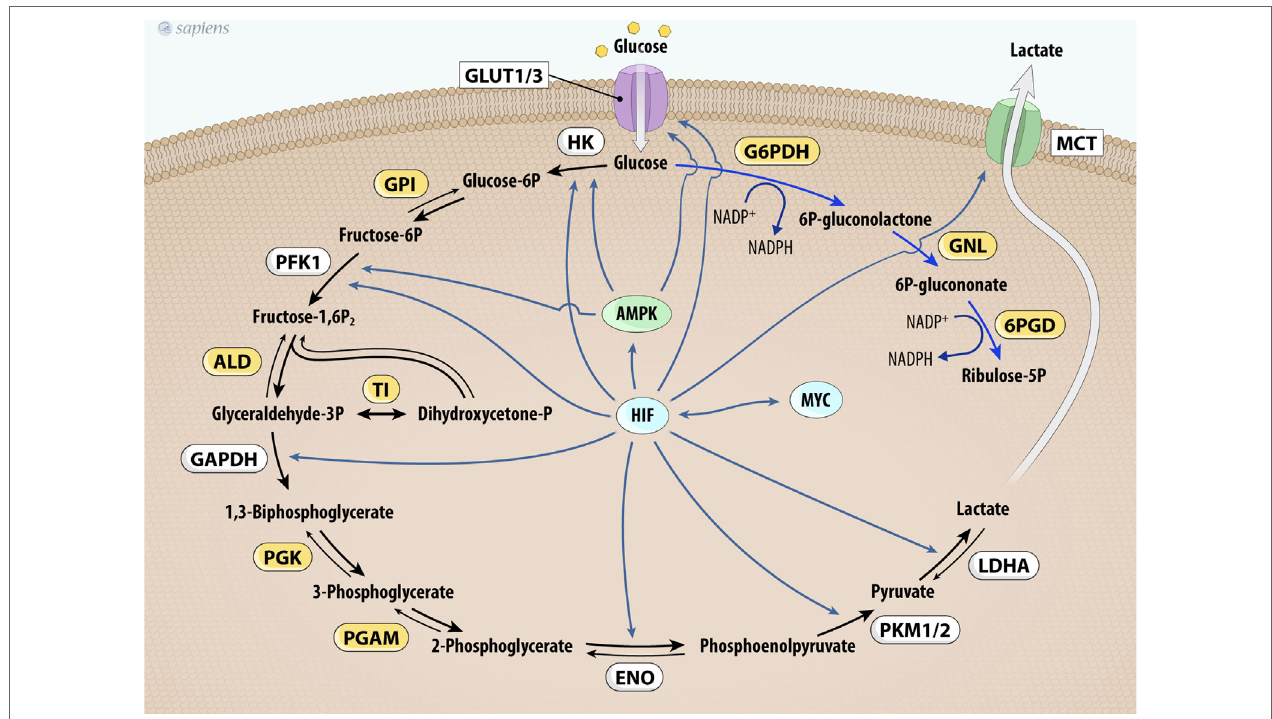
FiGURe 3 | MYC and HIF-1 regulate glucose metabolism. MYC and HIF-1 are described as important regulators of key genes (in white) involved in glucose uptake and glycolysis pathway control. Abbrevations: Glut1/3, glucose transporter 1 or 3; HK, hexokinase; GPI, glucose phosphate isomerase; PFK-1, phosphofructokinase 1; ALD, aldolase; TI, triose phosphate isomerase; GAPDH, glyceraldehyde 3-phosphate dehydrogenase; PGK, phosphoglycerate kinase; PGAM, phosphoglycerate mutase; ENO, enolase; PKM1/2, pyruvate kinase isoforms 1 and 2; LDHA, lactate dehydrogenase A; G6PDH, glucose 6-phosphate dehydrogenase; GNL, gluconolactonase; 6PDG, 6-phosphogluconate dehydrogenase; MCT1, monocarboxylate transporter-1; HIF-1, hypoxia-inducible